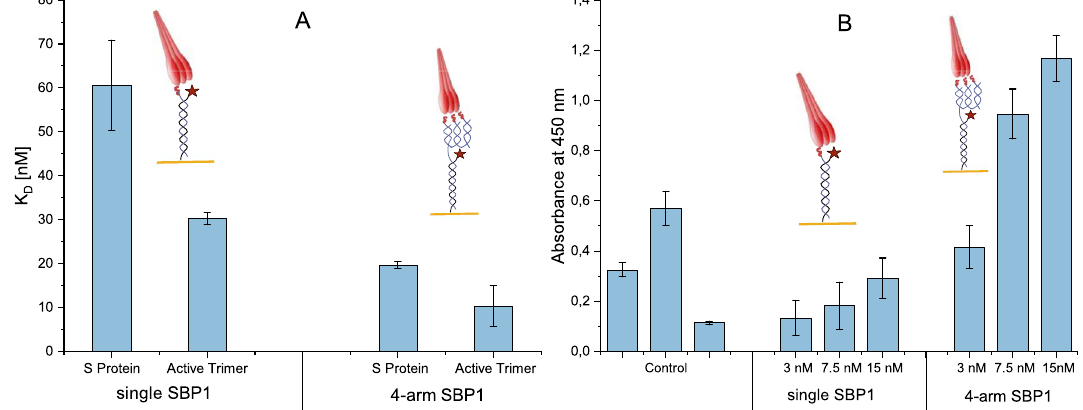
Figure 3. Spike protein binding to three or one peptide per DNA nanostructure. ( A ) Results from the switchSENSE measurements of the dissociation constants K D for the binding interaction of “SARS-CoV-2 S protein” and “SARS-CoV-2 S protein, active trimer” by Acro Biosystems to the monovalent peptide presenting DNA (single SBP1) and the trimeric peptide presenting DNA structure (4-arm SBP1). Trimeric peptide presentation reduces the dissociation constant by a third compared to the monovalent peptide presentation. The “SARS-CoV-2 S protein, active trimer” binds more strongly than the “SARS-CoV-2 S protein”, presumably due to variations in glycosylation and amino acid sequence variations. ( B ) Results from ELISA for a control, immobilized DNA with one peptide or three peptides and subsequent binding analysis of the “SARS-CoV-2 S protein, active trimer”. Here as well the trimeric presentation results in a significant increase of the signal compared to the monovalent peptide presentation. Although the experiment was repeated multiple times, the results shown here come from one well plate to allow for comparability.